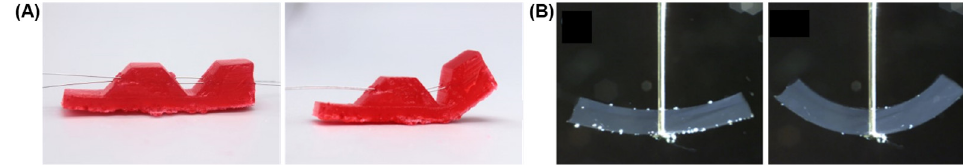
Figure 2. Bending actuators. ( A ) Mechanically actuated gelatin bending actuators with Nitinol wire and crosslinked with microbial transglutaminase ([64], original image). ( B ) pH-sensitive swelling bilayer gelatin actuator in water before and after deformation [41]. (Images ( A , B ) are licensed under CC BY 4.0 (http://creativecommons.org/licenses/by/4.0/ (accessed on 30 October 2022))).